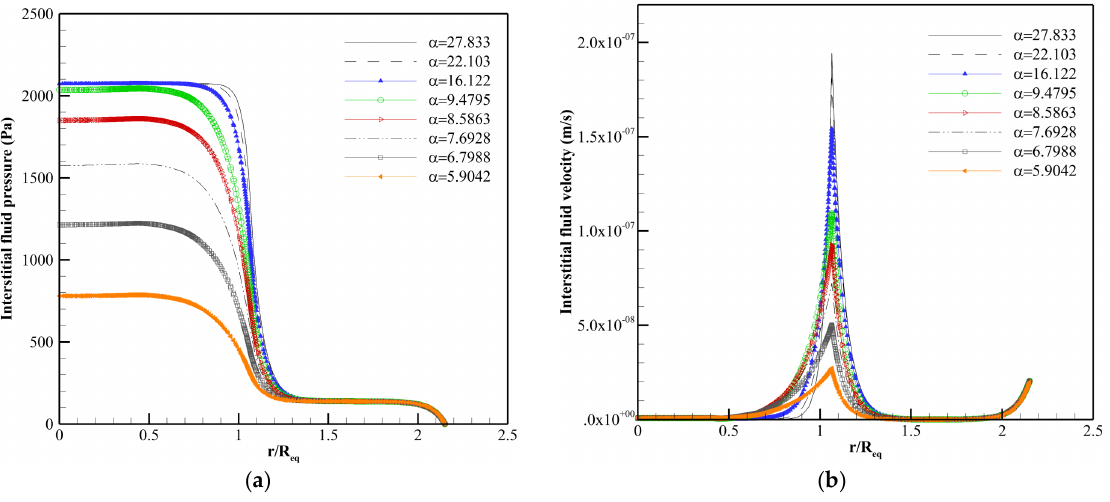
Figure 8. ( a ) IFP distribution along line 1. ( b ) IFV distribution along line 1.